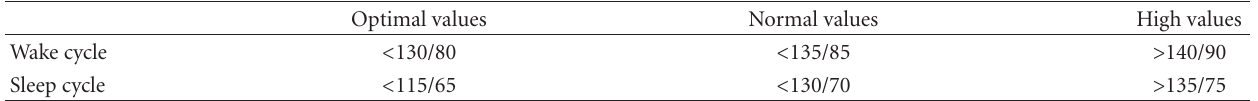
Table 1: Blood pressure values in adults according to